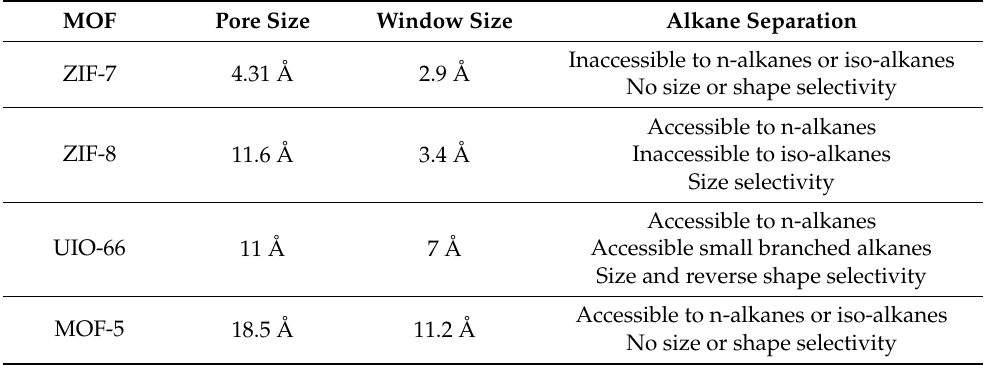
Figure 16. Gas chromatograms on the UiO-66 coated capillary column (20 m long × 0.25 mm i.d.) at a N 2 flow rate of 1 mL min − 1 for the separation of: ( A ) hexane, heptane, octane, and nonane using a temperature program of 60 ◦ C for 1 min, and then 40 ◦ C min − 1 to 250 ◦ C; ( B ) hexane, 2-methylpentane, 3-methylpentane, 2,3-dimethylbutane, and 2,2-dimethylbutane using a temper- ature program of 100 ◦ C for 1 min, and then 10 ◦ C min − 1 to 160 ◦ C; ( C ) 1,3,5-trimethylbenzene, n-propylbenzene, and iso-propylbenzene using a temperature program of 140 ◦ C for 1 min, and then 10 ◦ C min − 1 to 180 ◦ C; ( D ) m-, p-, o-xylene and ethylbenzene using a temperature program of 140 ◦ C for 1 min, and then 10 ◦ C min − 1 to 180 ◦ C. Reprinted with permission from [73]. Copyright (2012) Elsevier. Table 2. The effect of pore size and pore window size on the adsorption and separation of alkane molecules on several